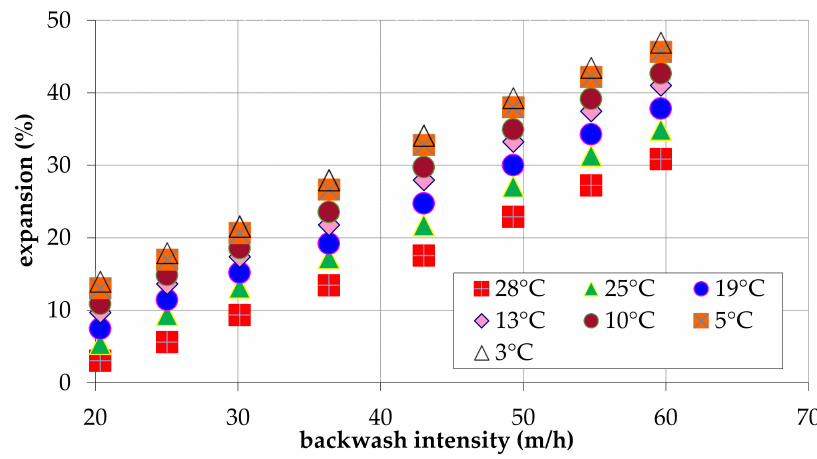
Figure 5. Sand expansion calculated according to the Richardson–Zaki Equation (3) with the exponent of the power “ n ” described by Equation (14) and the free sedimentation velocity according to the nature of motion calculated according to the equations presented in Table